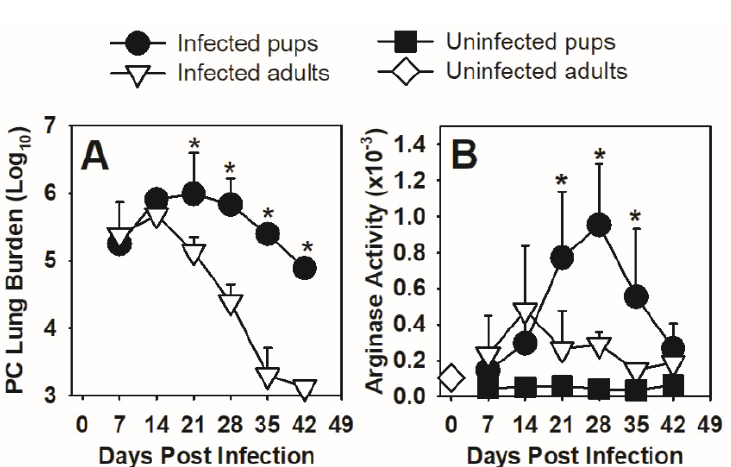
Figure A1. P. murina -infected neonatal mice have significantly higher arginase activity in the lungs than infected adults. B6D2F1 mice were infected at 2 days (neonate) or 8 weeks (adults) of age with 5 × 10 5 P. murina organisms/g of body weight. At indicated days post infection lung lobes were collected from 5–6 mice per group. ( A ) P. murina lung burden was determined by microscopic quantification of organisms. ( B ) Lung digest lysates were used to determine arginase activity within the lung. Data represent the mean ± SEM from 5–6 mice per group and are representative of 2 independent experiments. * p ≤ 0.05, comparing P. murina infected adults to infected neonates